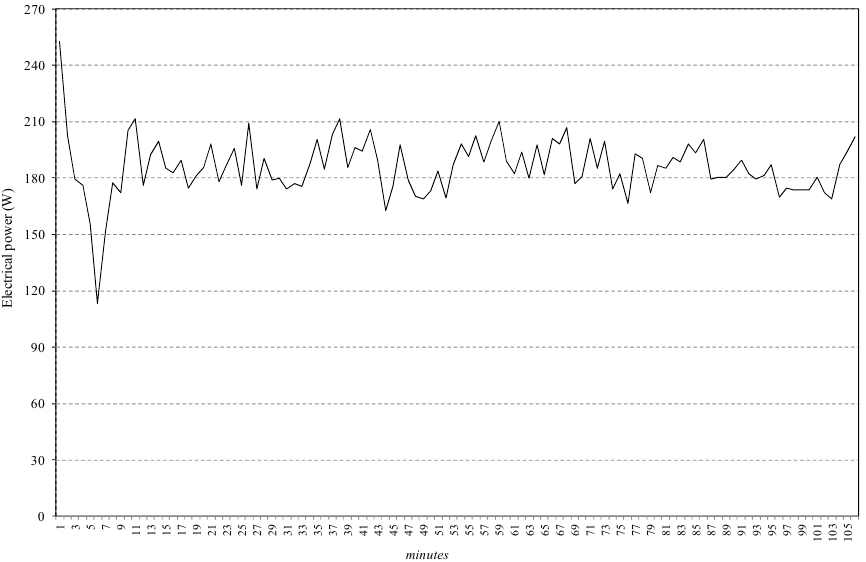
Figure 7. Electrical power of the experimental linear focus CPV/T system.